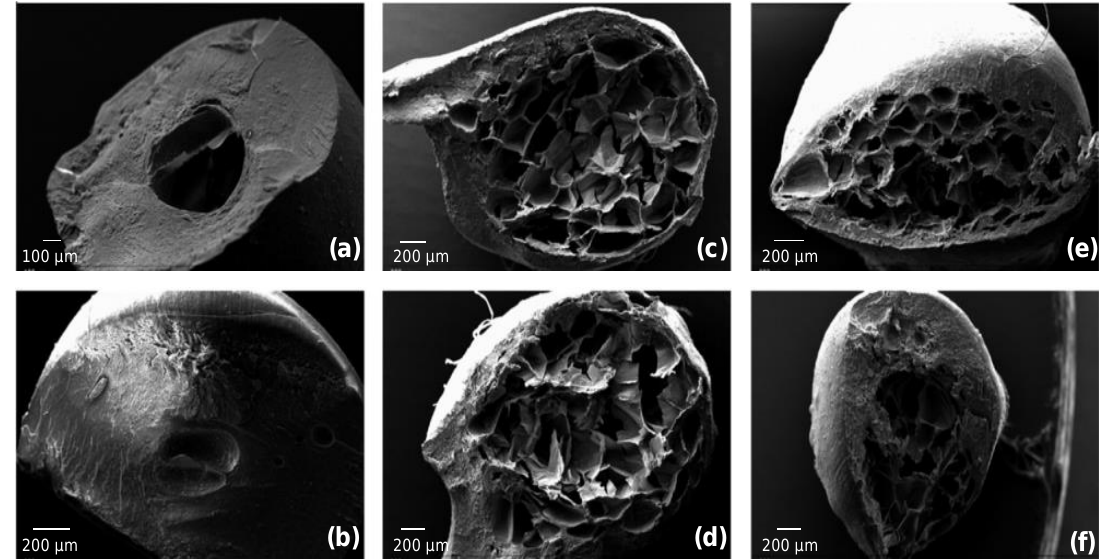
Figure 13. SEM microphotographs showing the hollow inner matrix of polysaccharide-based floating beads produced with different Pol 1 /Pol 2 /Pol 3 ratios: ( a , b ) 1.75:4:1, ( c , d ) 1.75:3:0.5 and ( e , f ) 1.25:3:0.5. Reprinted from [206] with permission from Elsevier. Copyright (2018).